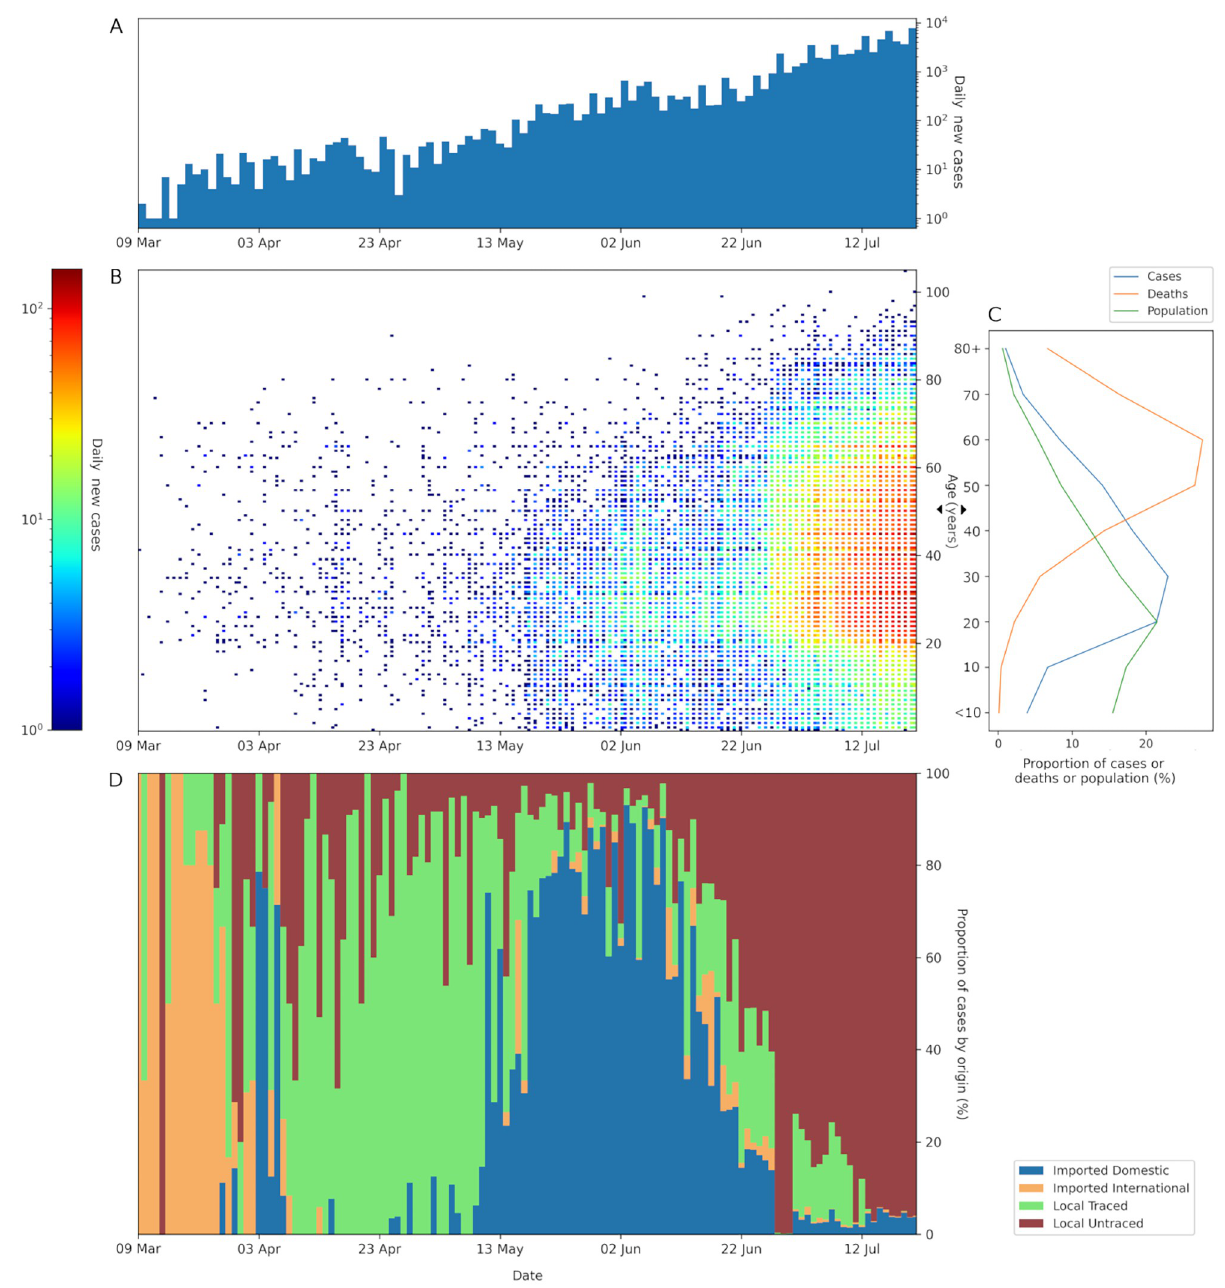
Fig 1. Epidemiological summary of the COVID-19 outbreak in Karnataka, India from 9 March to 21 July 2020 (n = 71068). [A] Number of daily confirmed cases across time. [B] Density scatterplot showing daily confirmed cases for various ages across time. [C] Distribution of population, COVID-19 cases and COVID-19 deaths across age groups. 10-year age brackets have been used starting from 0–9 years, and the last bracket is � 80 years. [D] Daily confirmed cases across time stratified by origin of infection- imported international, imported domestic, local with known origin, and local with unknown